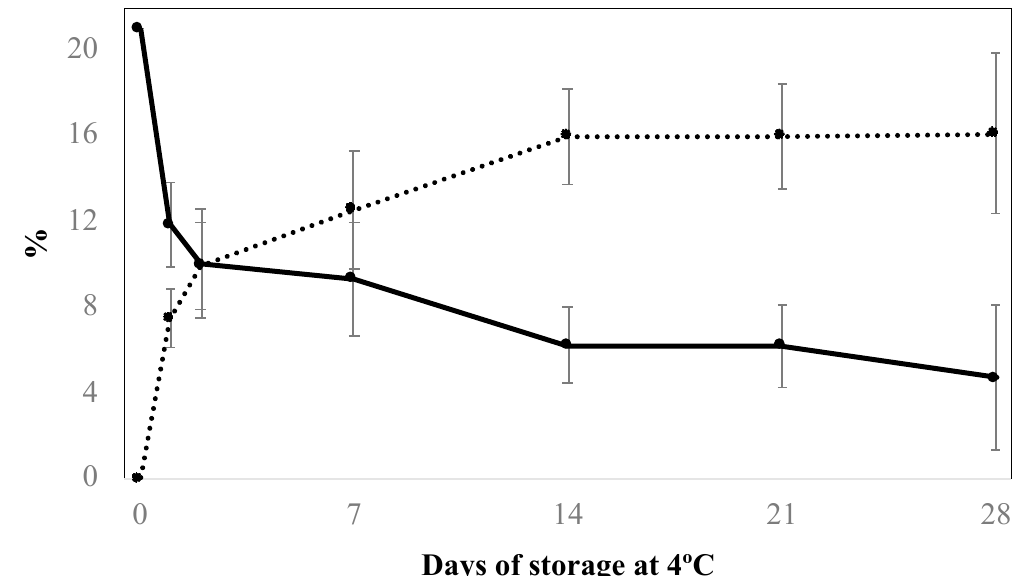
Figure 1. Time trend of CO 2 ( Figure 1. Time trend of CO 2 ( dashed line) and O 2 ( continuous line) of shiitake mushrooms dashed line) and O 2 ( Figure 1. Time trend of CO 2 ( dashed line) and O 2 ( continuous line) of shiitake mushrooms continuous line) of shiitake mushrooms packaged under modified atmosphere stored at 4 ◦ C. Data expressed as mean ± standard deviation packaged under modified atmosphere stored at 4 °C. Data expressed as mean ± standard deviation packaged under modified atmosphere stored at 4 °C. Data expressed as mean ± standard deviation Figure 1. Time trend of CO 2 ( dashed line) and O 2 ( continuous line) of shiitake mushrooms (SD) of three samples. (SD) of three samples. packaged under modified atmosphere stored at 4 °C. Data expressed as mean ± standard deviation (SD) of three samples.